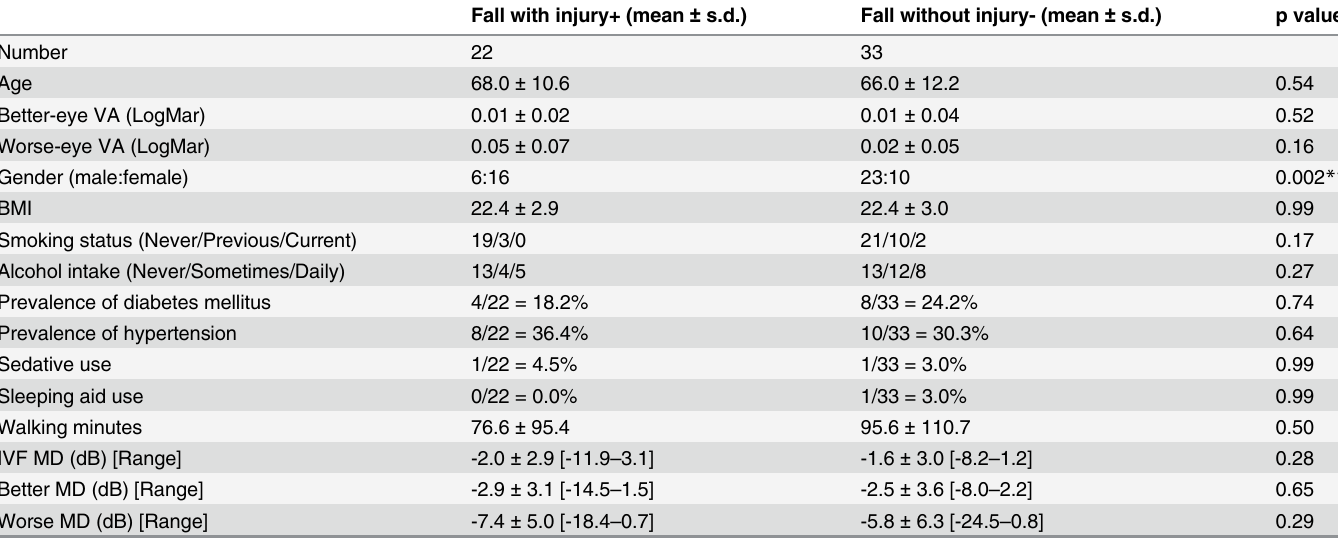
Table 2. Comparison of variables between fallers with and without a history of injury. Fall with injury+ (mean ± s.d.) Fall without injury- (mean ±